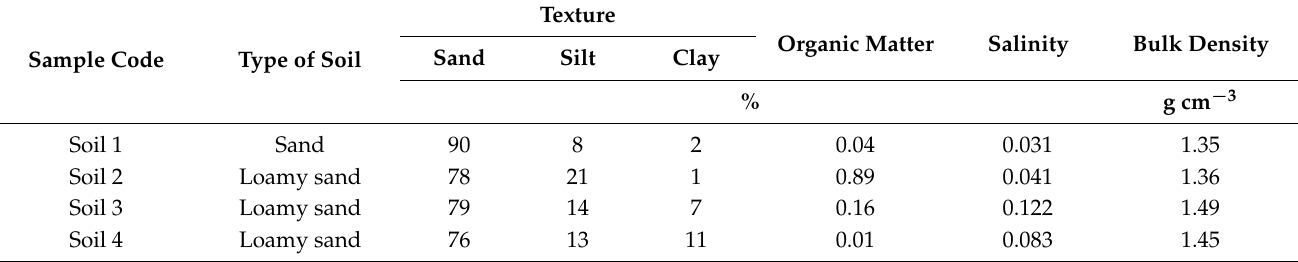
Table 1. Physical properties of 10 soil samples from different areas in